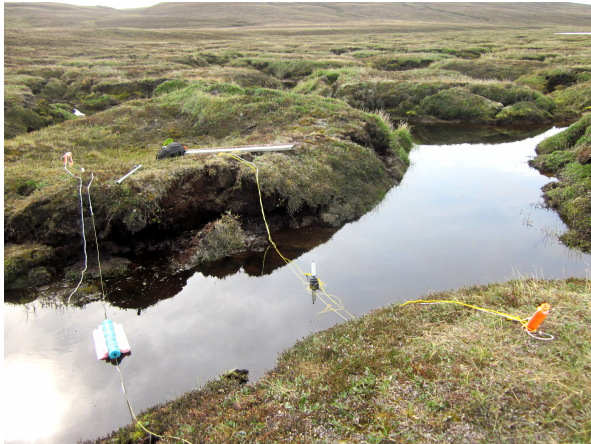
Figure C1. Picture of eroding shores (slumping peat) along trough pond BYL27 (photo taken in July 2014). The sampling funnel sy- ringe can be seen just above the water surface.